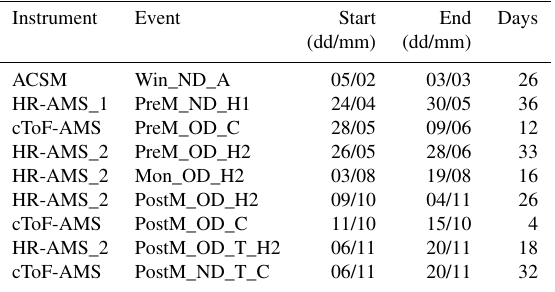
Table 1. Measurement dates and instrumentation. Winter (Win), pre-monsoon (PreM), monsoon (Mon) and post-monsoon (PostM). New Delhi (ND) and Old Delhi (OD) sites. ACSM (A), two HR-ToF-AMS instruments (H1 and H2), cToF-AMS (C). Eddy- covariance flux measurements tower